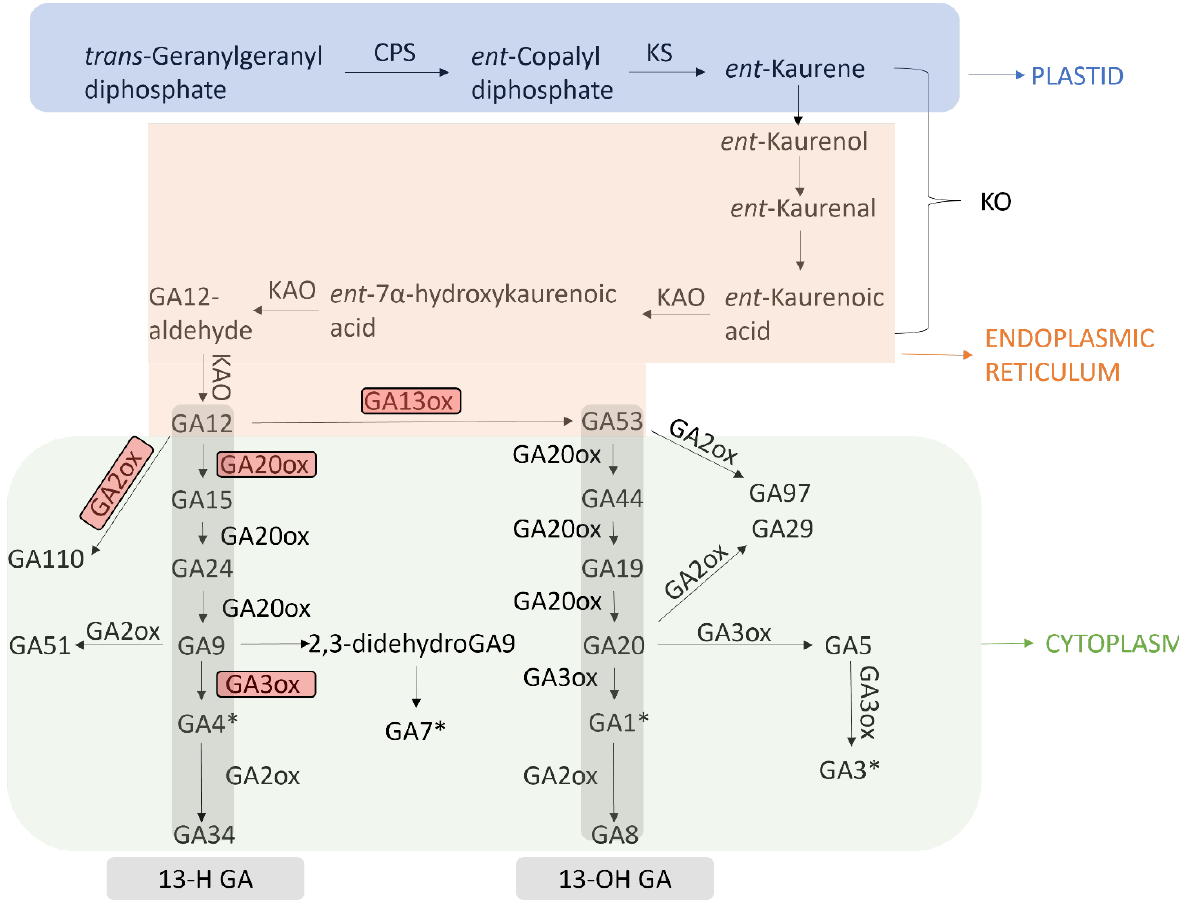
Figure 1. Gibberellin (GA) biosynthesis and deactivation pathways in Arabidopsis. CPS: ent -copaly1 diphosphate synthase; KS: ent -kaurene synthase; KO: ent -kaurene oxidase; KAO: ent -kaurenoic acid oxidase; GA13ox: GA 13-oxidase; GA20ox: GA 20-oxidase; GA3ox: GA 3-oxidase; GA2ox: GA 2-oxidase; red boxes indicate key enzymes; asterisks indicate bioactive GA; and 13-H GAs and 13-OH GAs are highlighted in grey; * : bioactive GA.